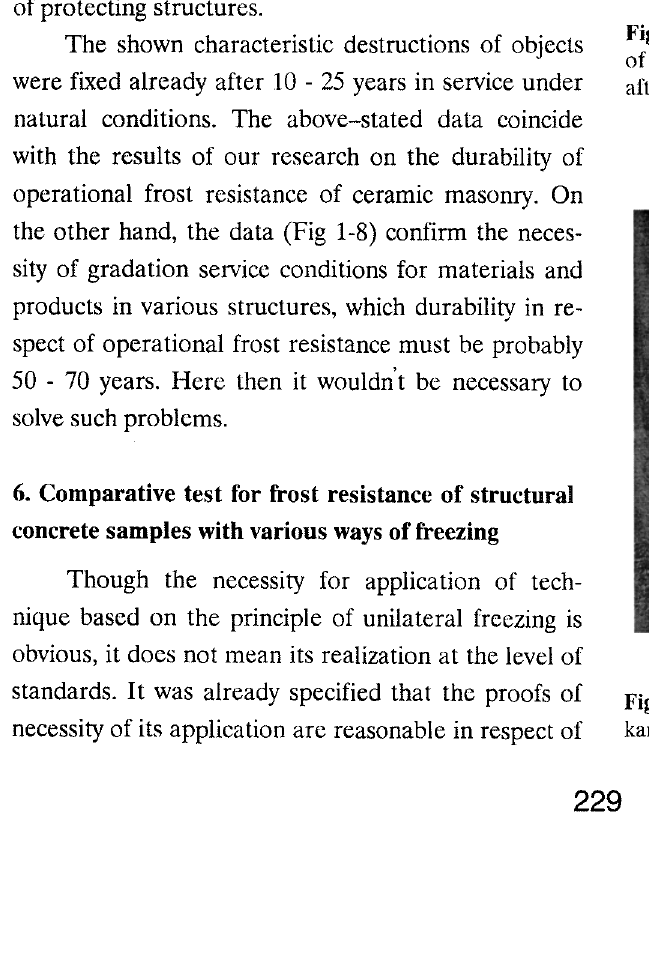
Fig 1. Destruction by exfoliation of decorative facing carpet of enameled ceramic tile of house facade in Ukmerges St 55 after 20 years of service under natural conditions